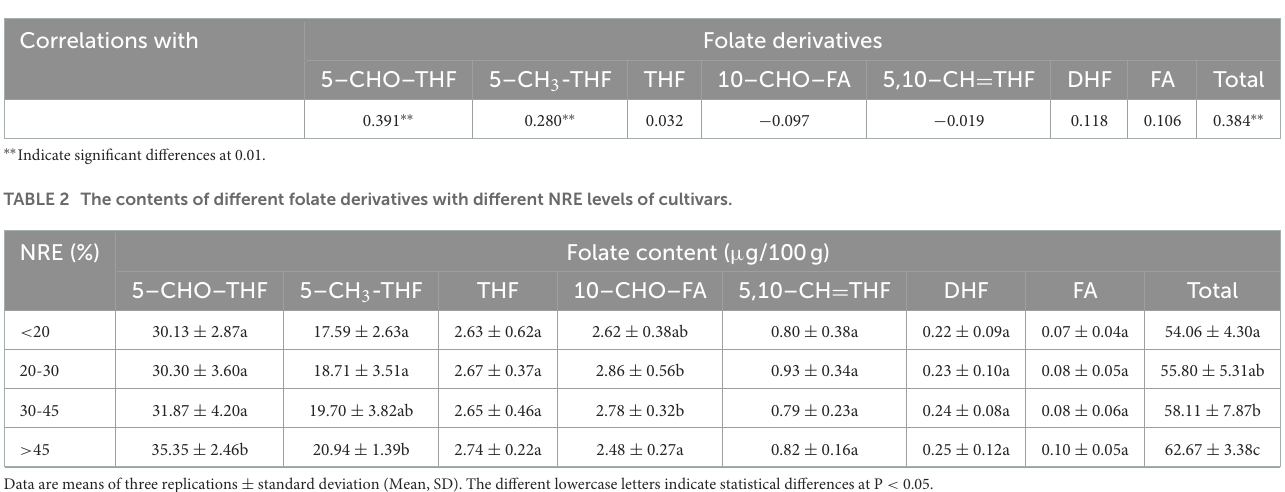
TABLE 1 Correlation between NRE and different folate derivatives with N application. Correlations with Folate derivatives 5–CHO–THF